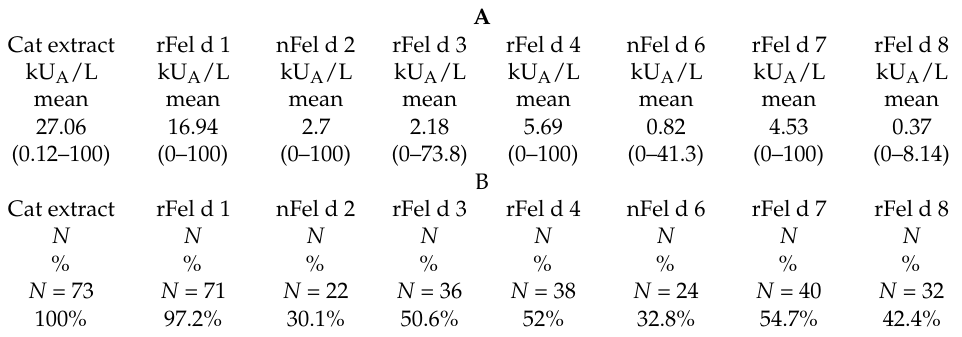
Table 2. Serological characteristics of patients with cat allergen-specific IgE antibodies. (A) Ranges and mean values of allergen-specific IgE levels. (B) Numbers and percentages of patients with allergen-specific IgE